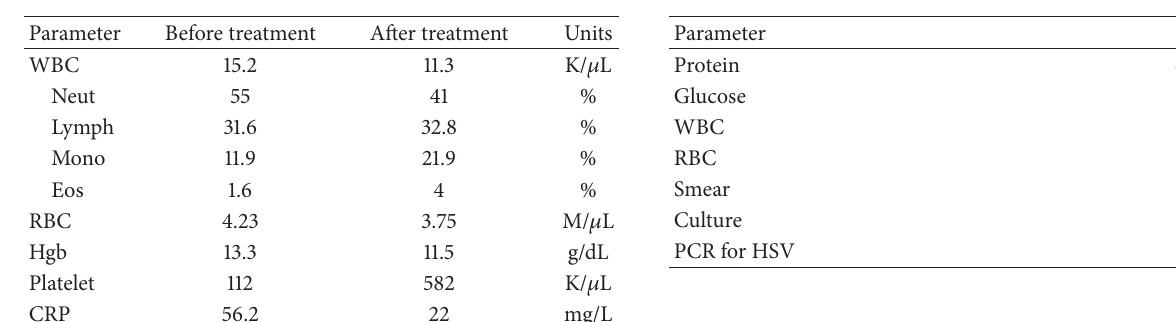
Figure 2: Dactylitis in the left foot.